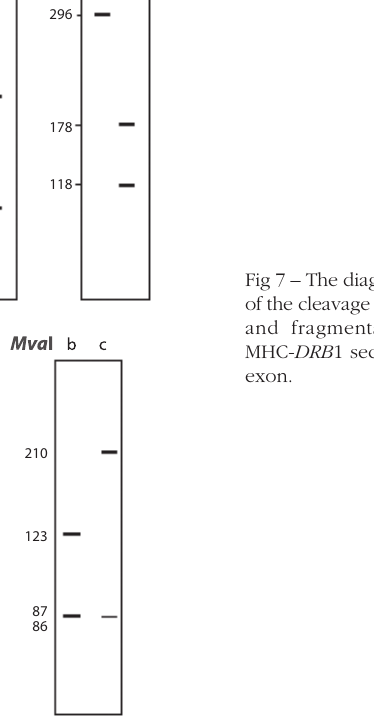
Fig 7 – The diagram of the cleavage sites and fragments in MHC- DRB 1 second